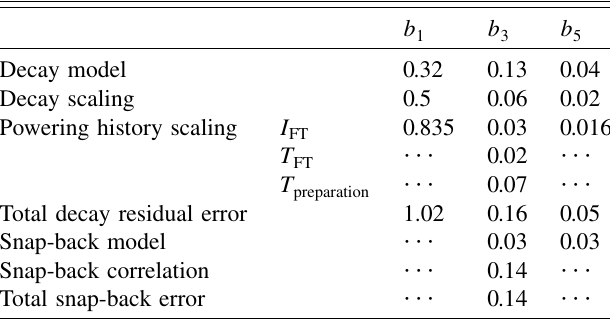
TABLE VI. Summary of the maximum residual error expected due to the dynamic model and scaling procedure. (All values are in units @ R ref